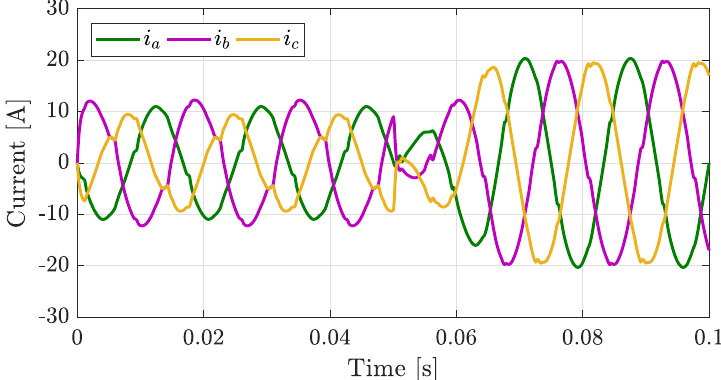
Figure 17. Compensation of PI controller tuned by poles placement method under unbalanced linear and nonlinear